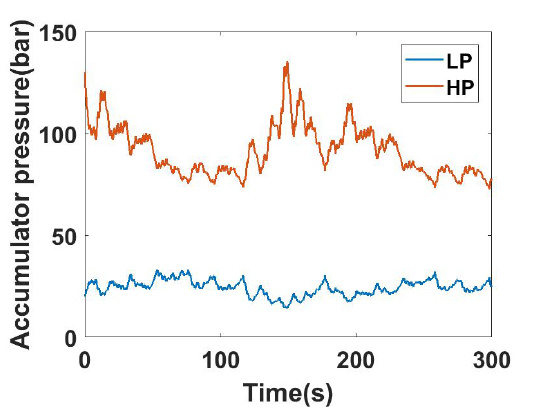
Figure 19. The pressure of the accumulator.